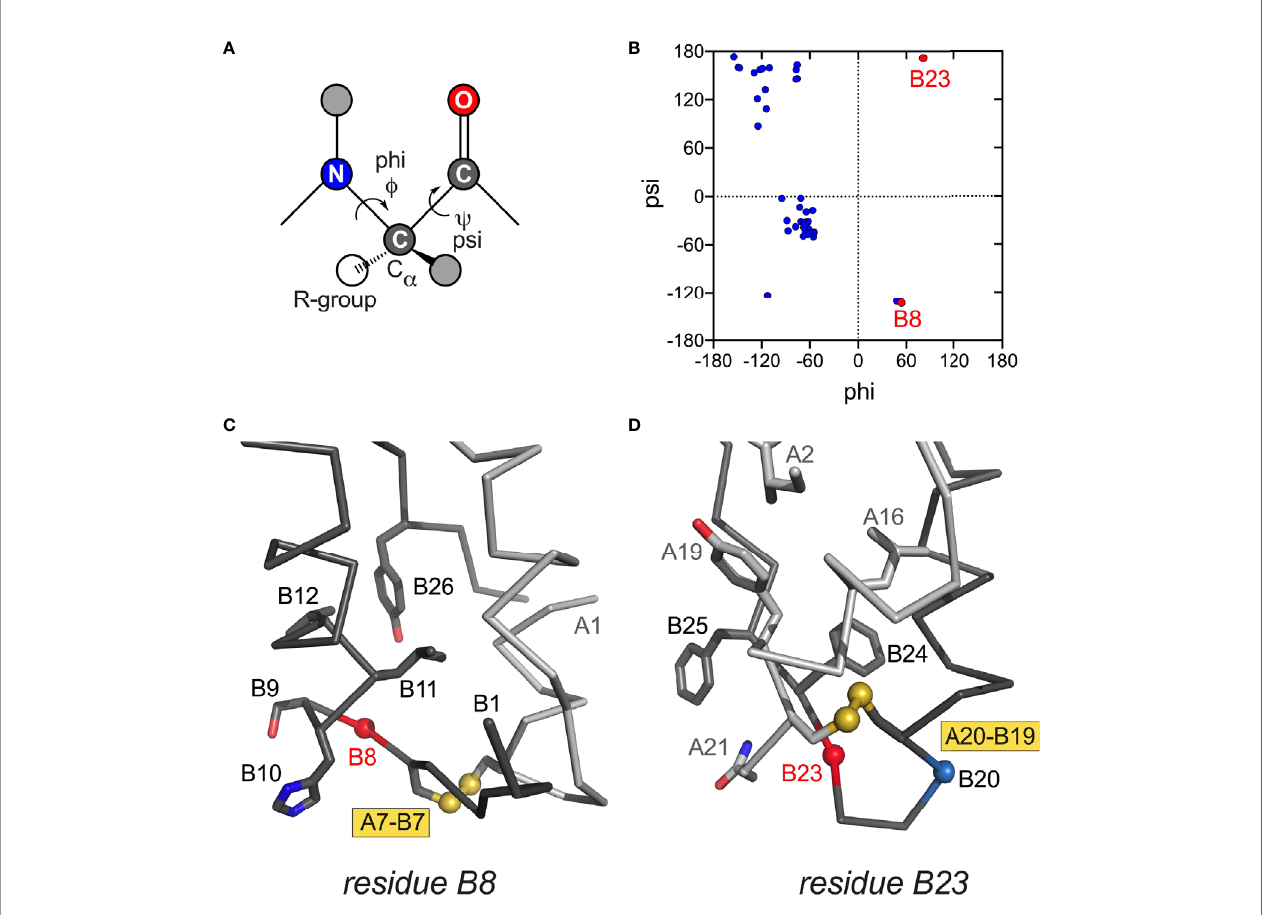
FIGURE 4 | Conformations and structural environments of conserved glycines at positions B8 and B23. (A) Main-chain dihedral angles phi ( j ) and psi ( y ) in a peptide. (B) Ramachandran plot of crystallographic insulin T state (PDB entry 4INS; j / y angles generated using PyMOL and plotted using GraphPad Prism software). Residues B8 and B23 are as labeled (red). In canonical T state Gly B8 and Gly B23 lie within b -turns with positive j – angles, thereby residing on the right side of Ramachandran plane in regions unfavorable or “ forbidden ” for L-amino acids. In R state Gly B8 residues in a -helix and so on the left side of Ramachandran plot (not shown). (C) Canonical environment of Gly B8 in the T-state b -turn; key nearby side chains are shown. (D) Canonical environment of Gly B23 in B20-B23 b -turn, shared by T- and R states. Residue B23 is near the side chain of Asn A21 , and the positive B23 j angle enables formation of an inter-chain hydrogen bond (A21 side- chain carboxamide NH … O=C B23). Nearby side chains are shown. a -Carbon traces of the A- and B chains are shown in light- and dark gray, respectively. Coordinates were obtained from PDB entry 4INS